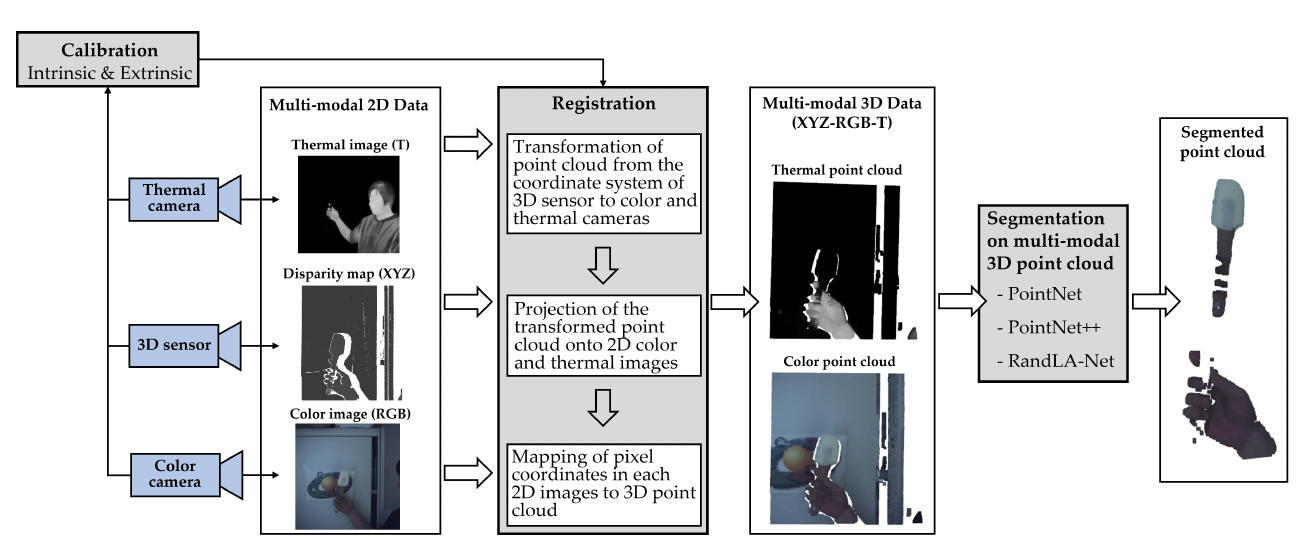
Figure 1. Workflow for a hand–object segmentation approach using a multimodal 3D sensor system containing a 3D sensor, an RGB camera, and a thermal camera.